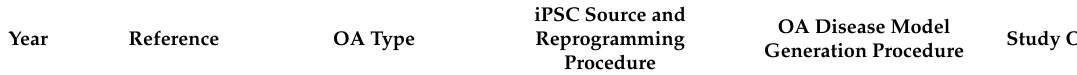
Table 1. Summary of disease modeling in OA and early-onset